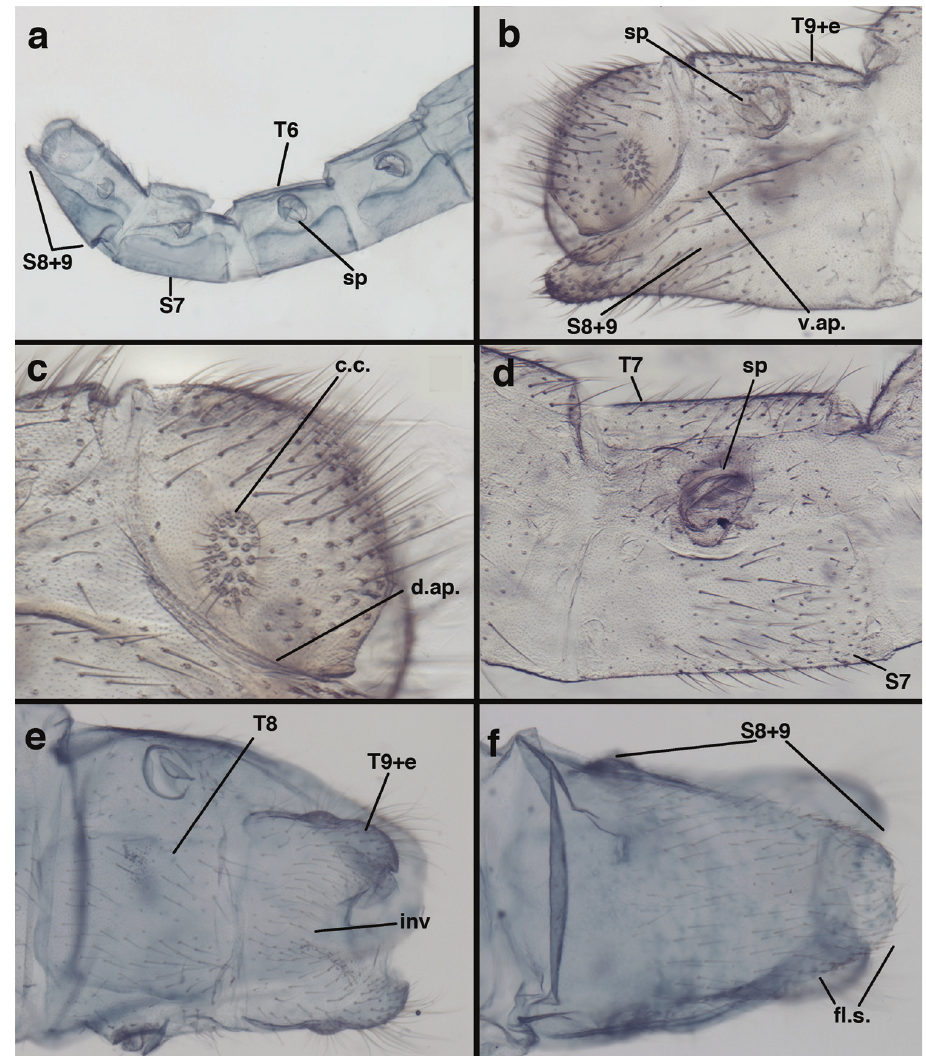
Figure 28. Ungla demarmelsi Sosa: Male abdomen, ( a ) segments A5-terminus, lateral ( b ) terminus, lat- eral ( c ) fused ninth tergite+ectoproct, lateral ( d ) seventh segment, lateral ( e ) eighth tergite and fused ninth tergite+ectoproct, dorsal ( f ) sternite 8+9, ventral. c.c. callus cerci d.ap. dorsal apodeme fl.s. flanged setae inv dorsal invagination of T9+ectoproct sp spiracle T6, T7, T8 sixth, seventh, and eighth tergites T9+e fused ninth tergite and ectoproct S7 seventh sternite S8+9 fused eighth and ninth sternites v.ap. ventral apodeme ( a, e, f Venezuela, Mérida, UCDC; b, c, d Venezuela, Distrito Capital, USNM).